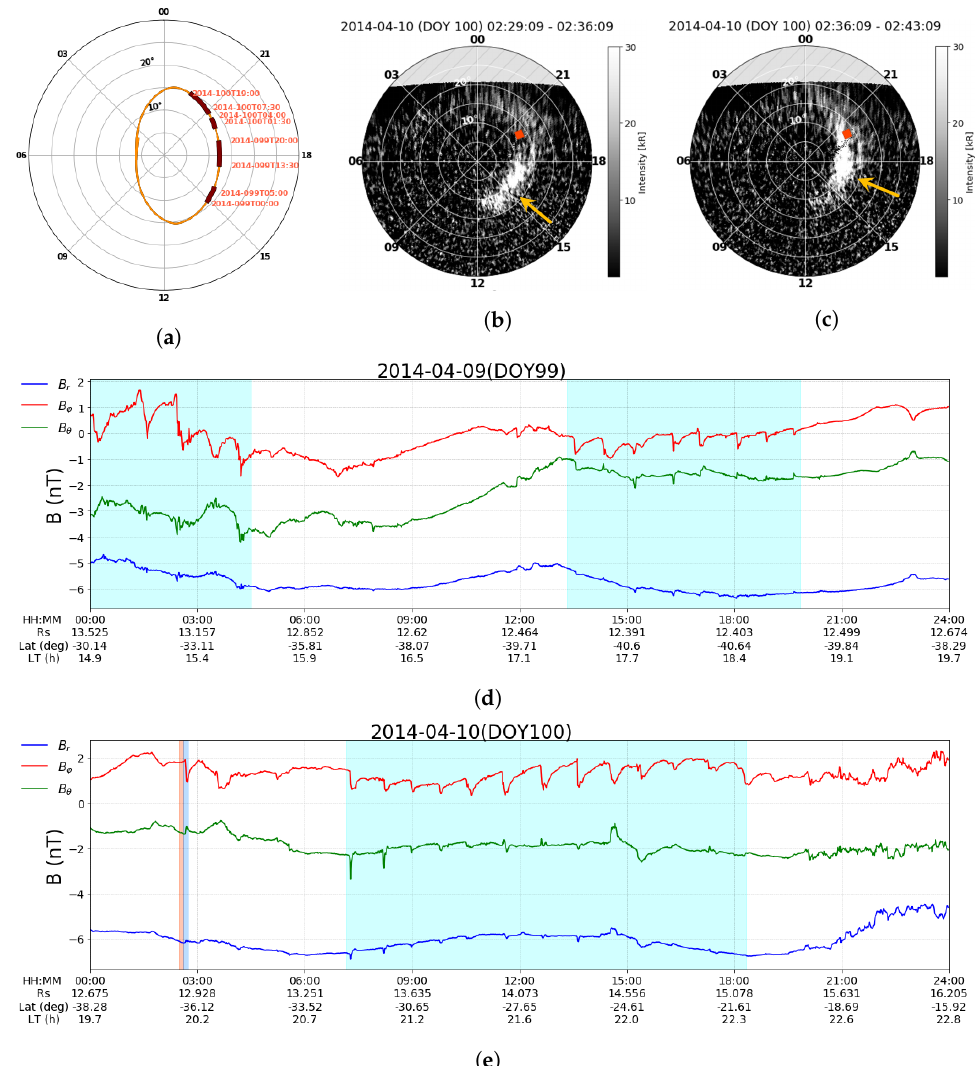
Figure 3. ( a ): Trajectory of Cassini spacecraft from 2014-80 to 2014-120 (orange path), obtained using SPICE, projected onto the Kronocentric polar plane, with 4 QP pulsation sequences identified in MAG data (red thick chunks) during this interval. ( b , c ): HST images of Saturn’s northern hemisphere in polar projection for the frames during the 2014-100 event (sequence no.13). The polar projection is the same as Figure 1, and the integration time of the images is 420 s. ( d , e ): 24-h in-situ magnetic field measurement in KRTP coordinates by Cassini magnetometer. Red and blue stripes represent the time when a transient flash was observed by the HST, while the cyan shades highlight a series of pulsed events in the magnetic field outside of HST’s observation